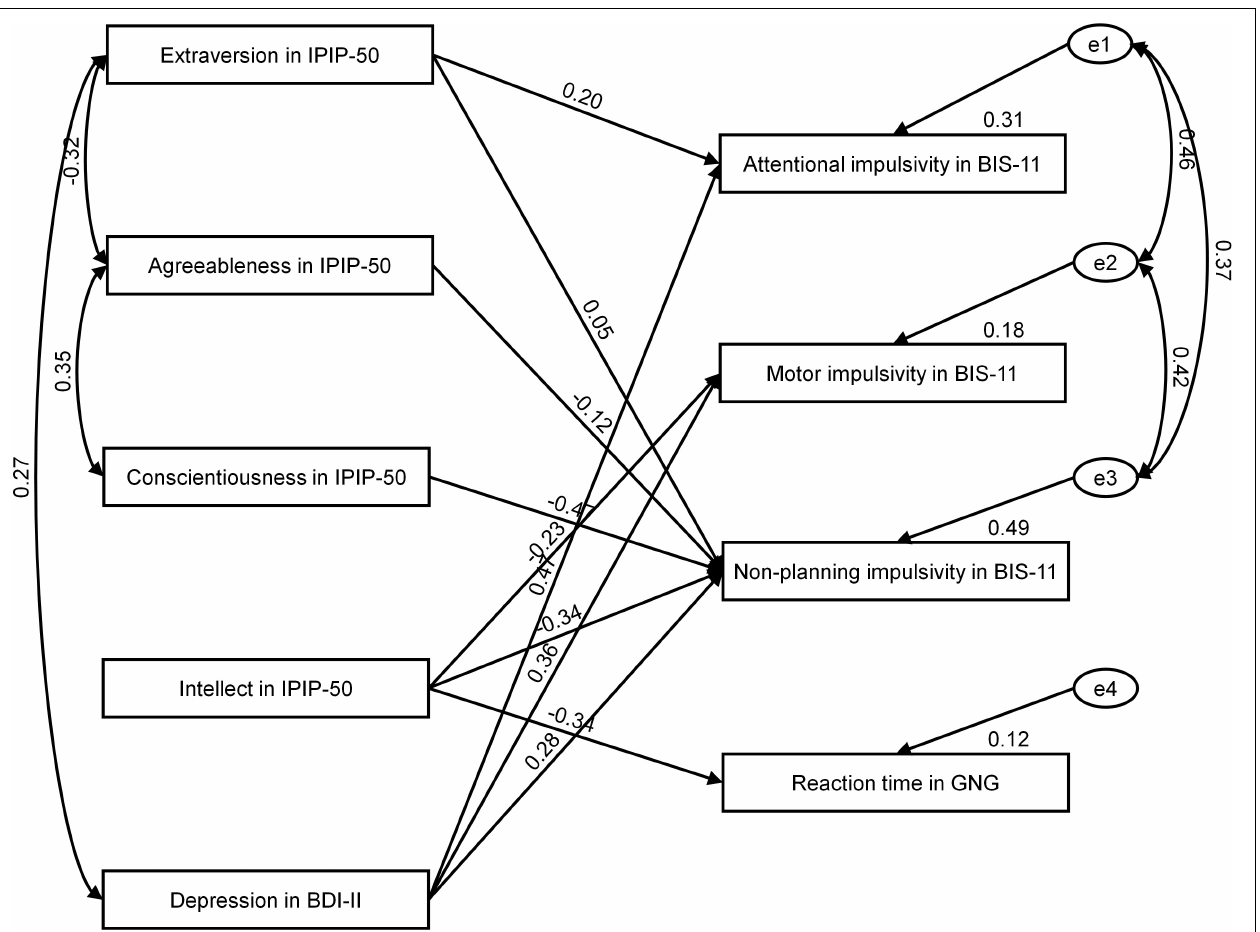
FIGURE 1 | Personality and depression symptomatology as predictors of impulsivity and processing